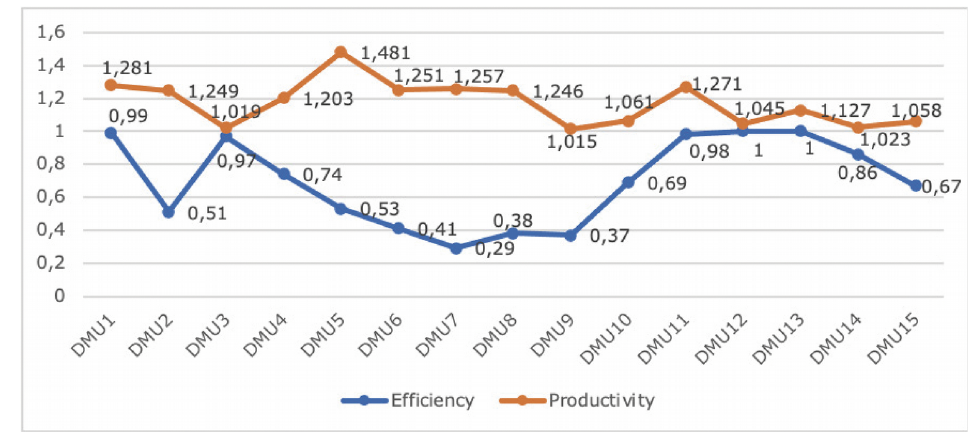
Figure 1. Efficiency score and productivity index of all DMUs